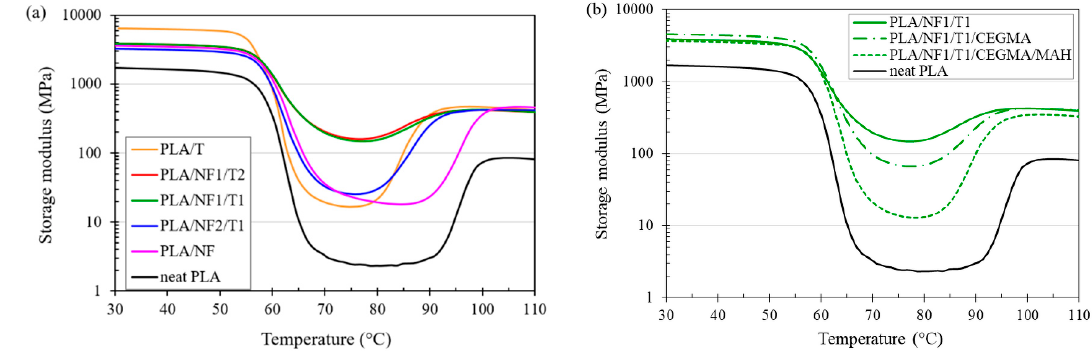
Figure 4. Plot of storage modulus against temperature of PLA hybrid composites at: ( a ) different fillers ratios; ( b ) with and without various reactive compatibilizers.